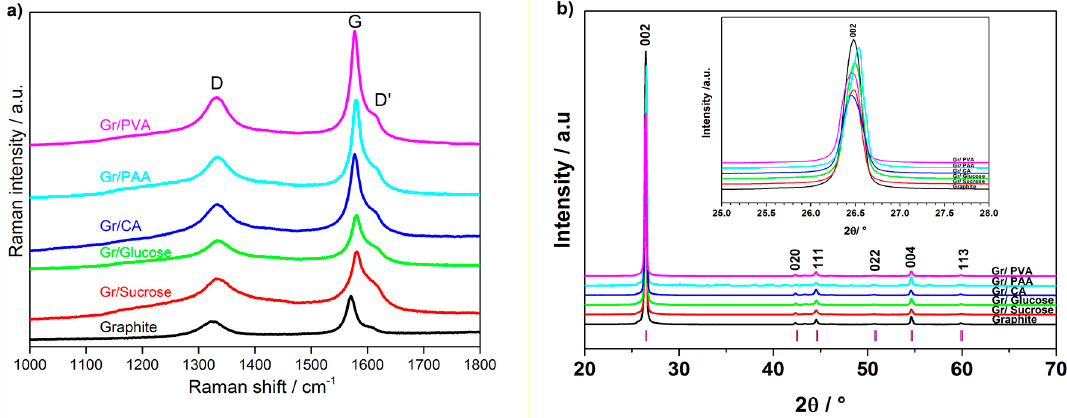
Figure 4. ( a ) Raman spectra and ( b ) X-ray diffraction (XRD) patterns of pristine and coated graphite samples.